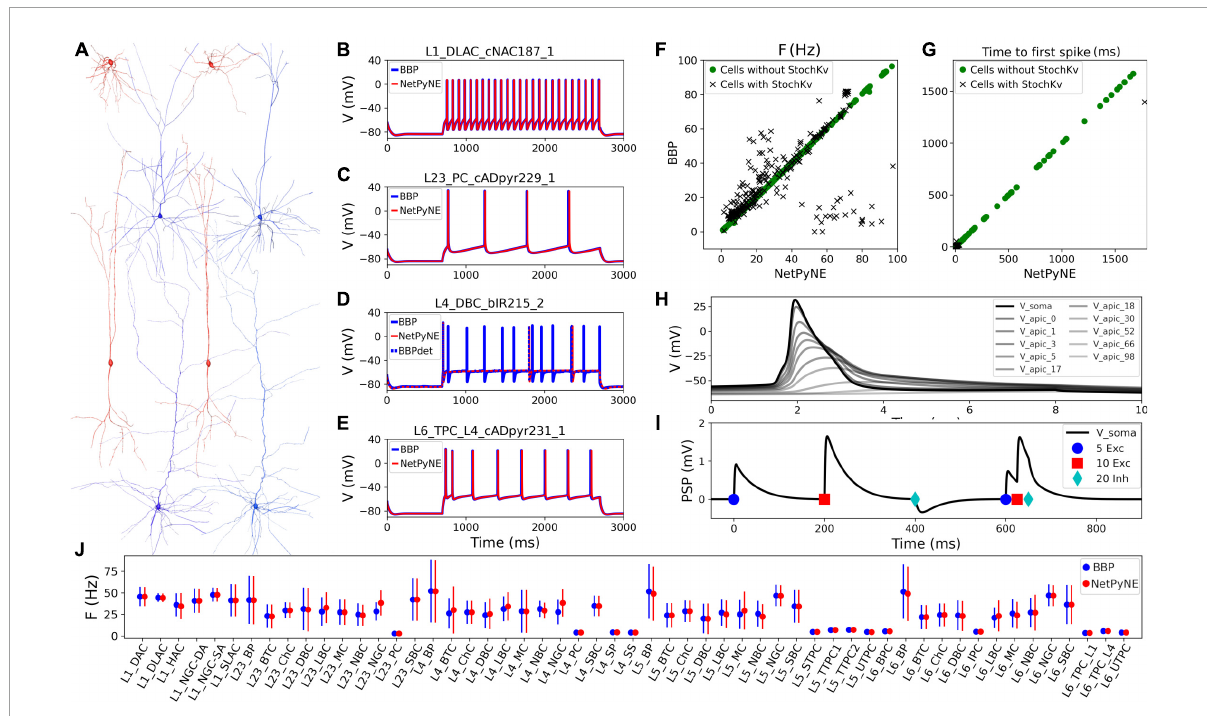
FIGURE1 Reproduction and validation of BBP S1 cell types in NetPyNE. (A) 3D reconstructions of 4 pairs of m-type example neurons visualized using the NetPyNE graphical user interface: inhibitory cells L1_DLAC and L4_DBC (red), and excitatory cells L23_PC and L6_TPC_L4 (blue). (B–E) Somatic membrane potential of the neurons in (A) under current clamp with amplitude 120% of the neuron firing threshold. NetPyNE results (red) compared to the original BBP model results (blue). For L4_DBC_bIR cells (D) we used a deterministic version of the BBP stochastic potassium channel (StochKv) resulting in divergent results; using same deterministic channel in BBP (BBPdet, blue dotted line) restores the match to NetPyNE results. (F,G) Comparison of BBP and NetPyNE firing rate and time to first spike in response to current-clamp with amplitude 0.1 nA during 2 s for each cell type. Only some cell types with the StochKv show differences. (H) Backpropagating action potential in a L5_TTPC cell. (I) Post synaptic potentials (PSPs) of one dendritic connection with 5 excitatory (blue circles), 10 excitatory (red squares), and 20 inhibitory (cyan diamonds) synapses. (J) Comparison BBP and NetPyNE mean firing rate for all m-type populations. Due to the small number of cells with StochKv (3.6%), NetPyNE population firing rates closely match those of